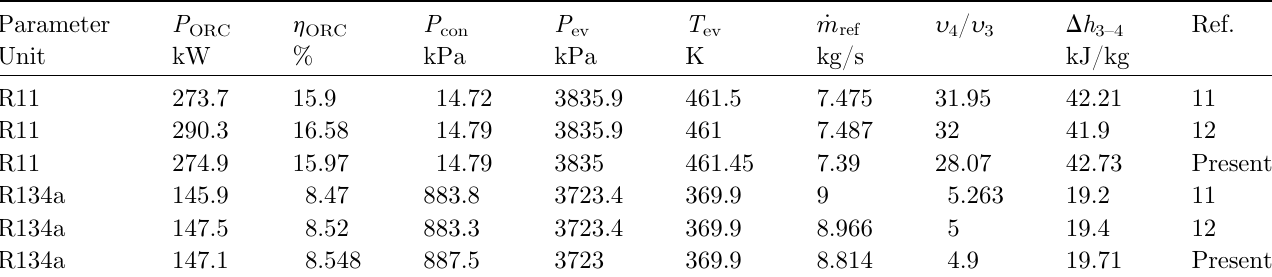
Table 3. Validation of the numerical model with the previously published data